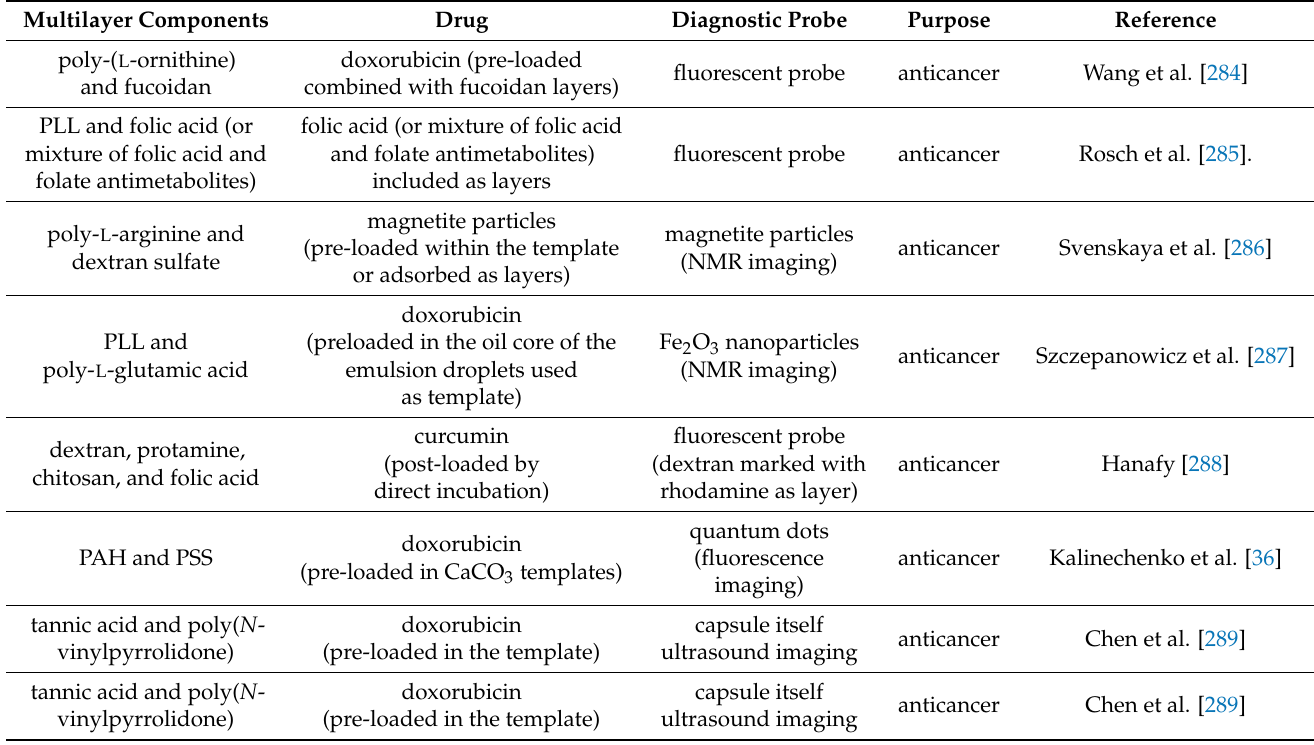
Table 5. Summary of multilayered capsules used for theranostic